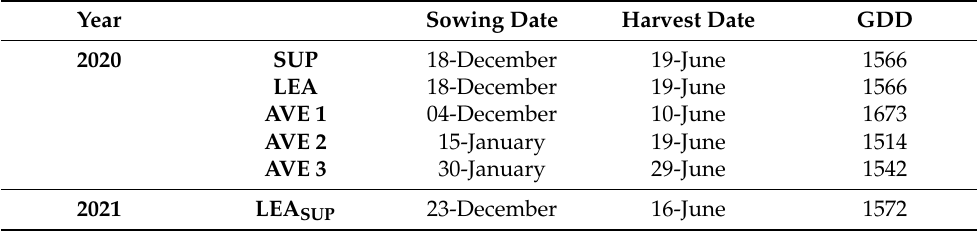
Table 5. Observed CGDD and dates of the different growing stages for the two years of the